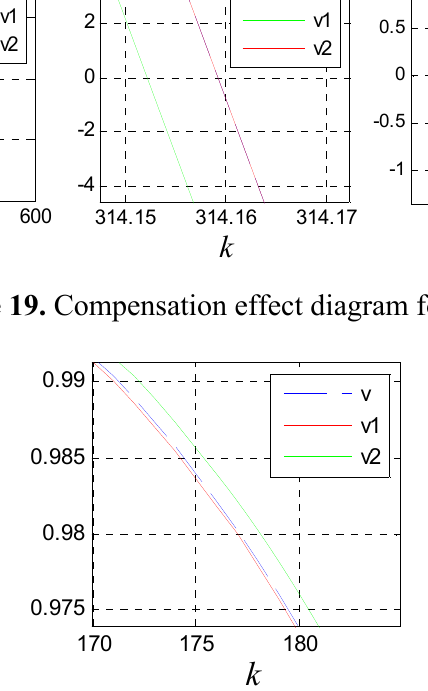
( k ) with different scale when ô is known precisely. 1